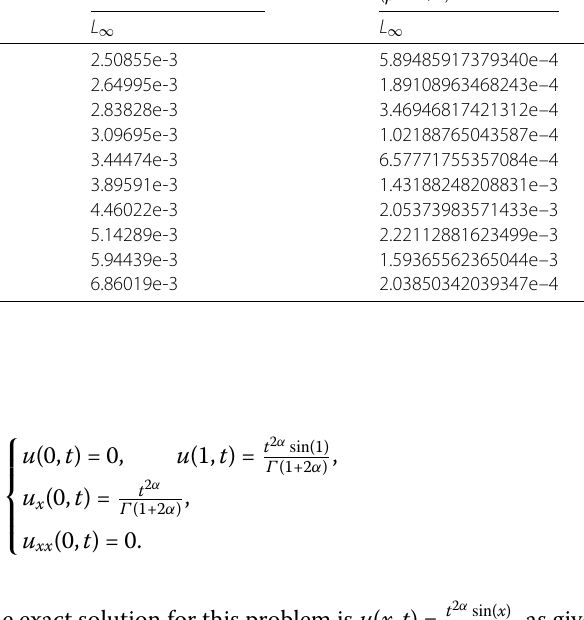
Table 3 Comparison of L ∞ errors of Example 1, for α = 1 and various values of x Legendre Wavelet Method in